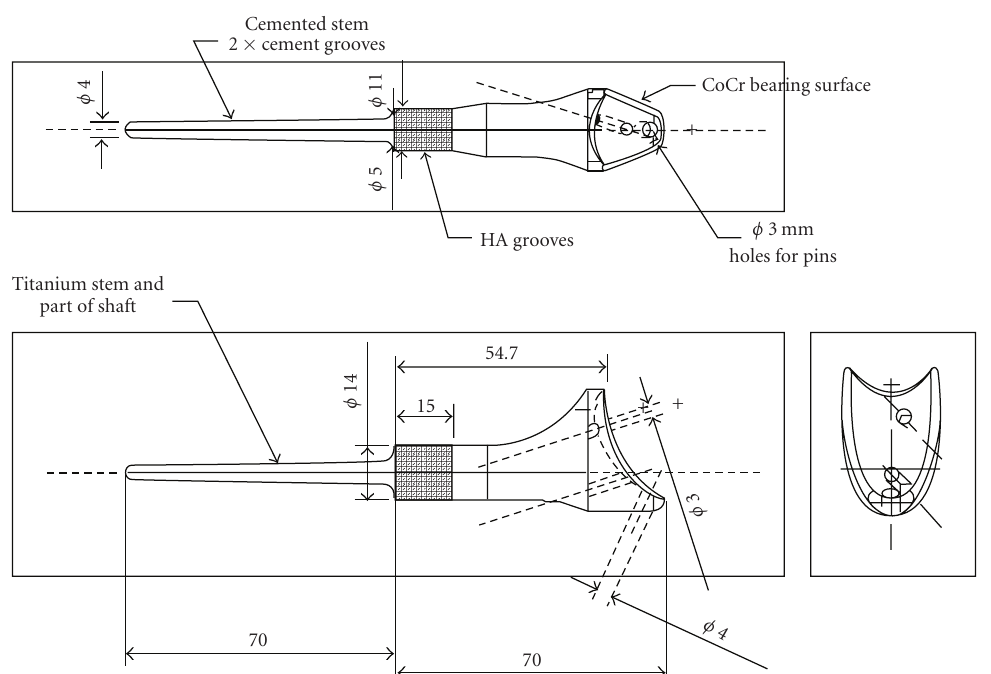
Figure 2: Template of a predominantly titanium distal radius prosthesis with a cobalt-chrome articulating surface (and measurements taken from contralateral forearm radiographs).